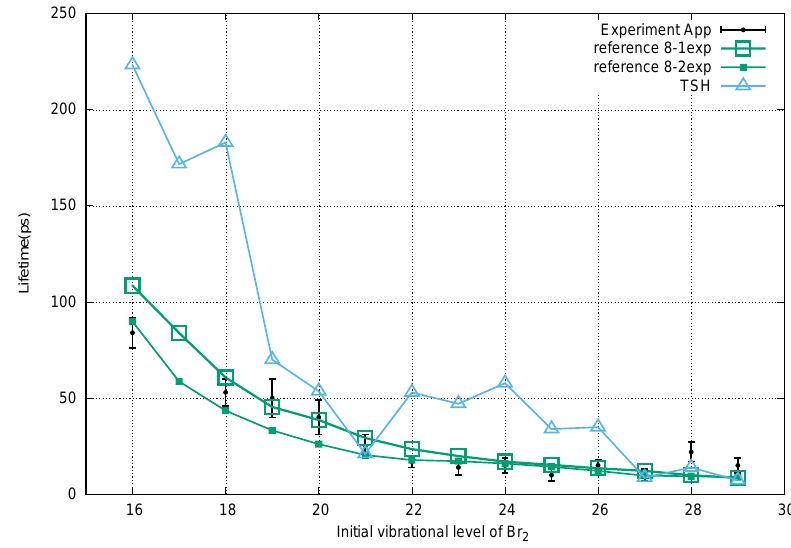
Figure 4. Lifetime for different initial vibrational level of Br 2 .